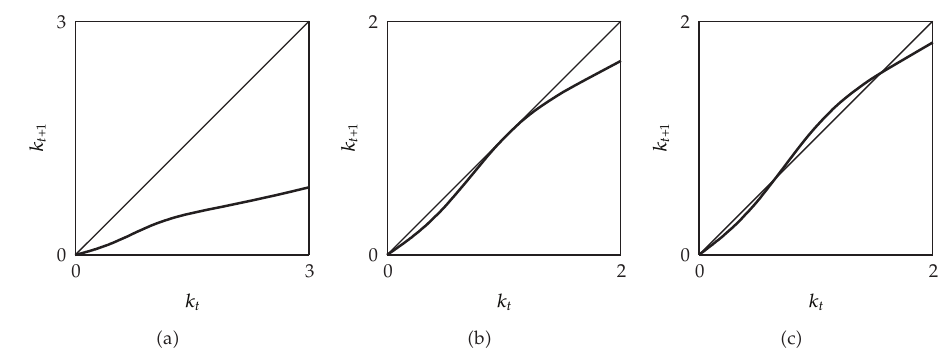
Figure 1: Map F and its fixed points in the case of strict monotonicity for the following parameter values: β (cid:7) 0 . 5, s w (cid:7) 0 . 2, s r (cid:7) 1, p (cid:7) 3, δ (cid:7) 0 . 2, α (cid:7) 0 . 3. In (cid:3) b (cid:6) n (cid:7) αG (cid:3) k 0 (cid:6) − δ (cid:7) 0 . 1606 (cid:7) n ; in (cid:3) a (cid:6) n > n , in (cid:3) c (cid:6) n < n .